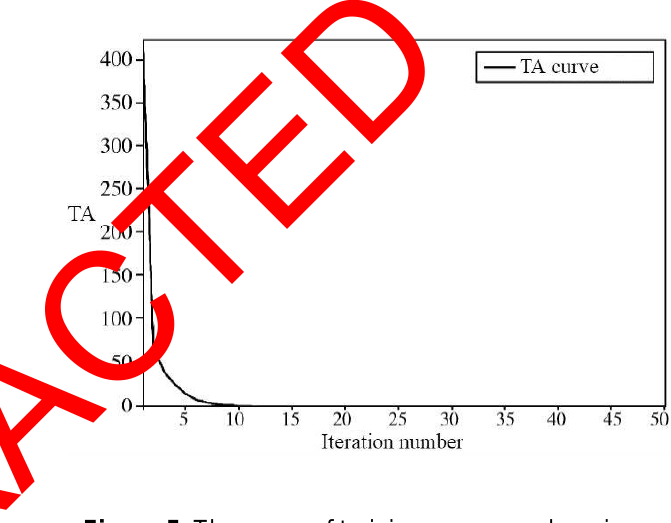
Figure 5. The curve of training accuracy changing with iteration